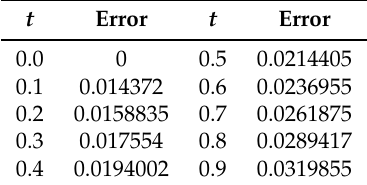
Table 4. Absolute errors in the solution of System (12) with quadrature method and h = 0.05, n = 20.